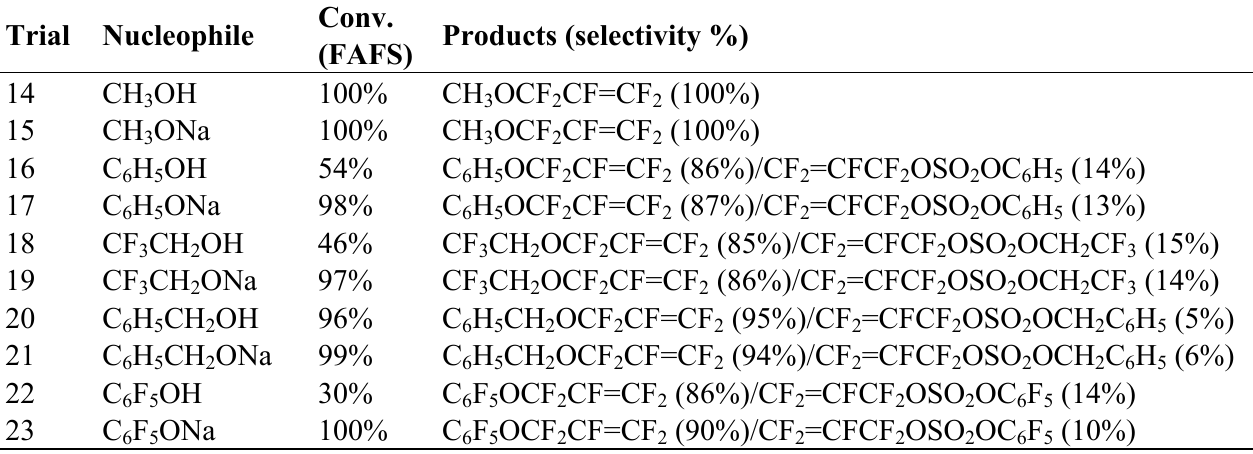
Table 4. FAFS regioselectivity with several oxygen